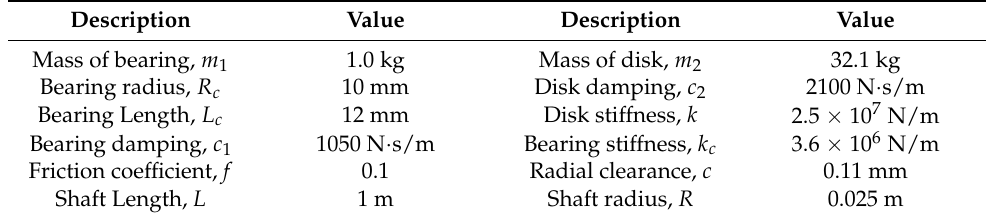
Table 1. Parameter values of the rotor–bearing